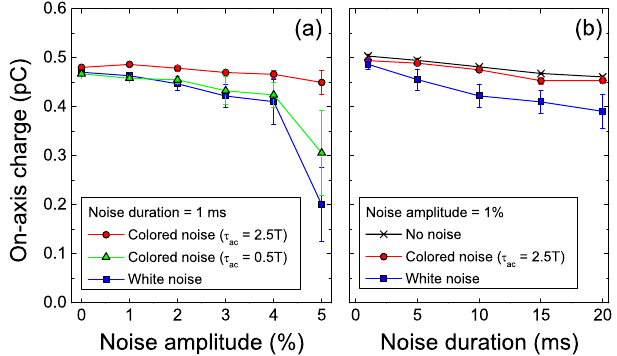
FIG. 8. (Color) Dependence of the on-axis charge signal on (a) noise amplitude, and (b) noise duration for white ( (cid:5) ac ¼ 0 ) and colored noise ( (cid:5) ac > 0 ). The error bars indicate the standard deviation of the on-axis charge calculated over 20 error samples.